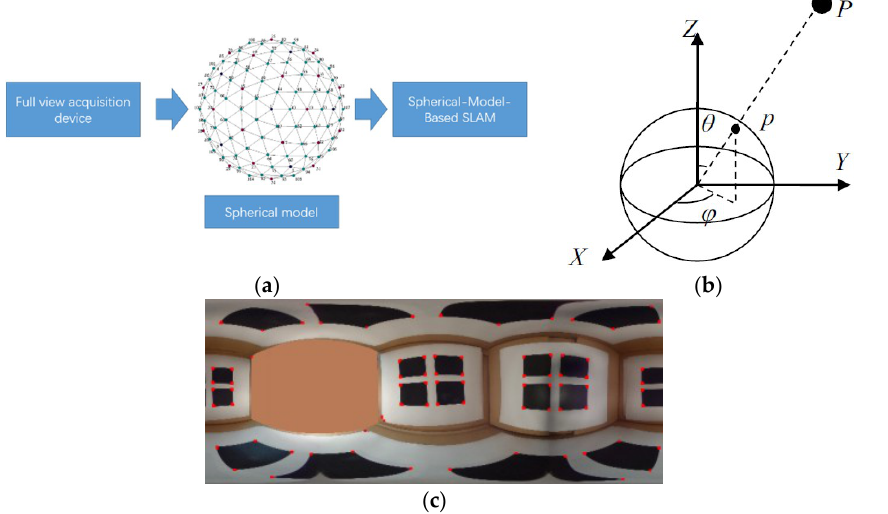
Figure 3. ( a ) the proposed method is based on the discrete spherical image; ( b )The spherical projection model; ( c ) full-view image.